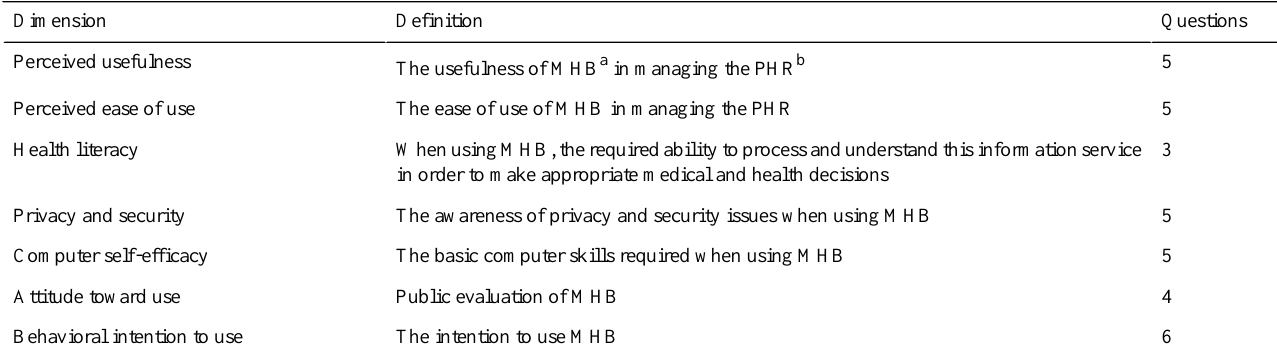
Table 1. Questionnaire